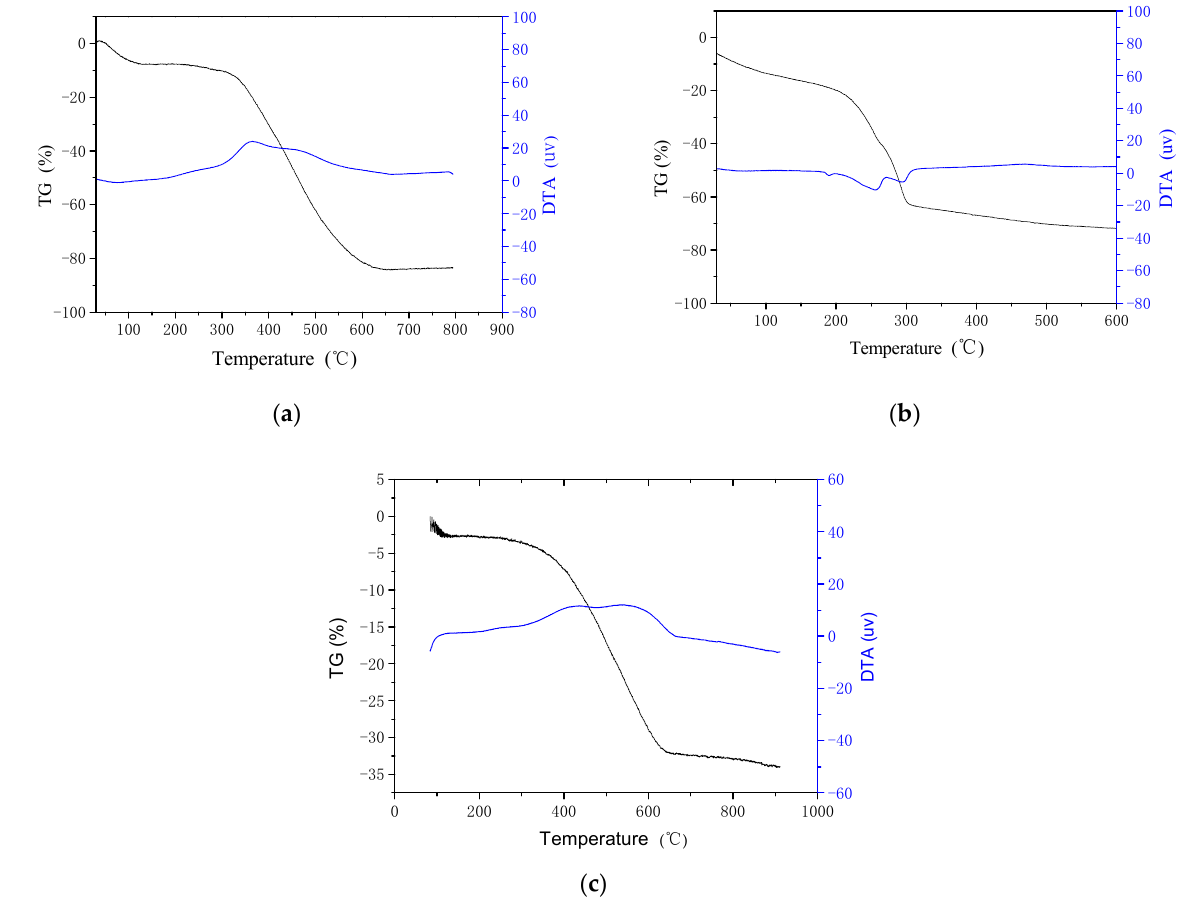
Figure 5. Thermogravimetric Analysis-Differential Thermal Analysis ( TG-DTA) curves. ( a ) PANI; ( b ) tin hydroxide; ( c ) PANI/SnO 2 .